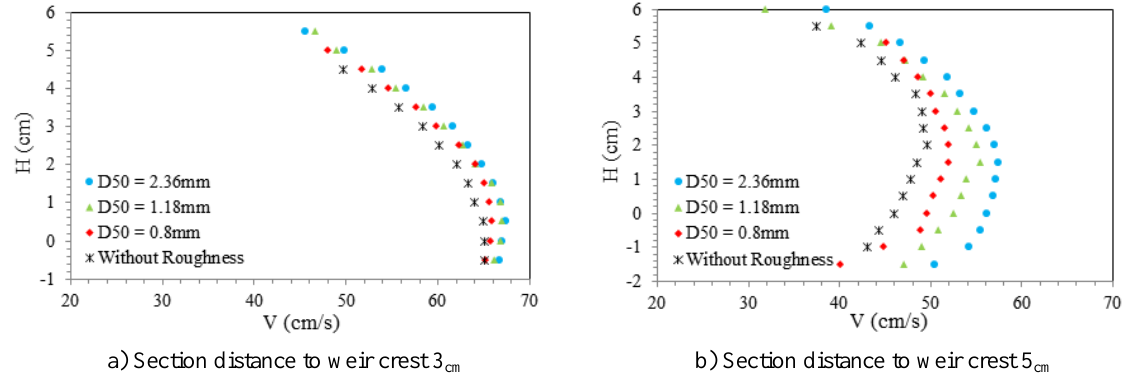
Fig. 8. Velocity profile at different sections before weir crest for different roughness sizes (Q =14 l/s) (H = 0.0 indicates weir crest elevation). cm